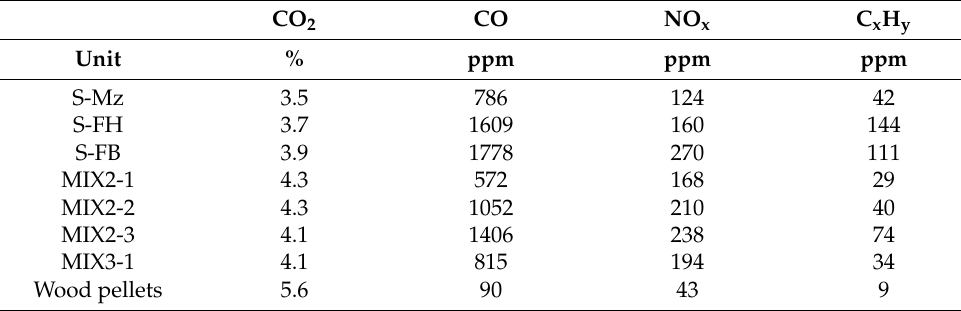
Table 4. Harmful emissions by burning